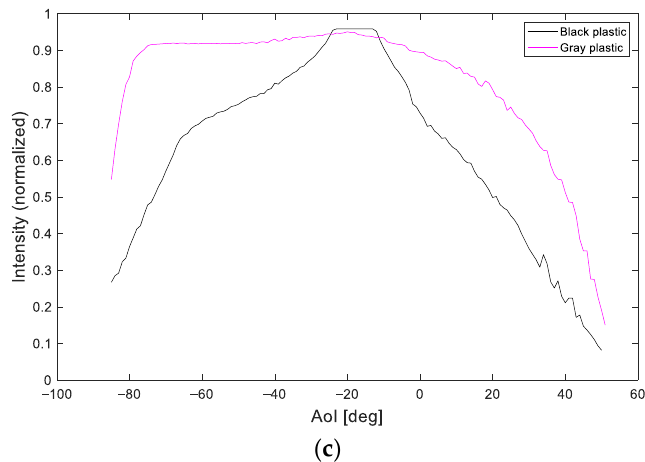
Figure 16. The processed intensity of non-transparent plastics of different colors: ( a ) Black; ( b ) gray; ( c ) median values in each measured position for non-transparent plastic samples.